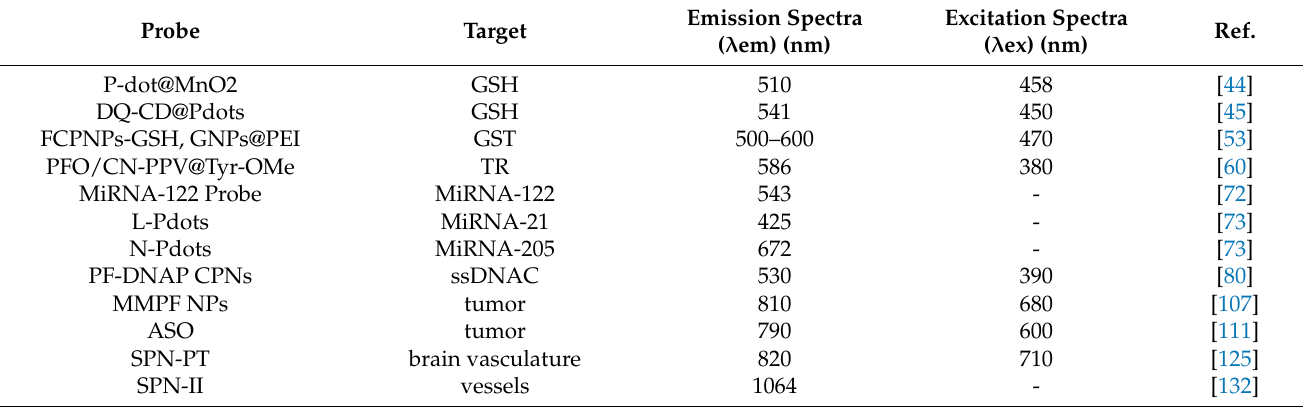
Table 1. The important parameters of OSNs